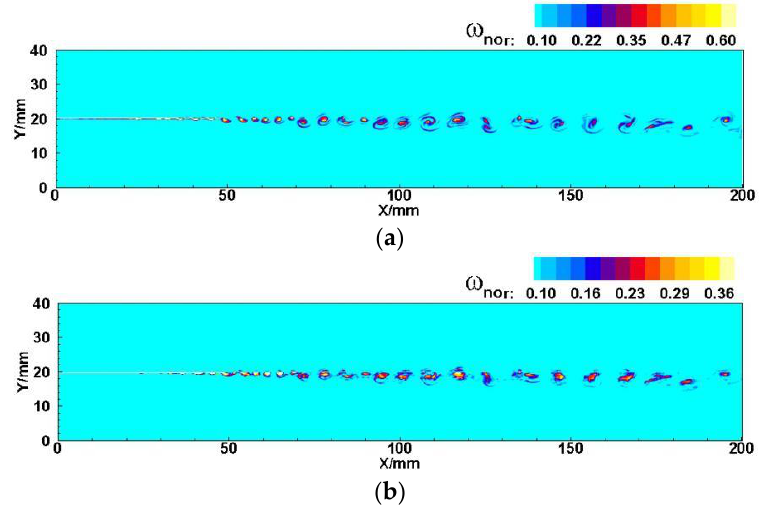
Figure 12. Comparison of original flow field and DMD reconstructed flow field: ( a ) original flow field of case 1; ( b ) constructed flow field of case 1.